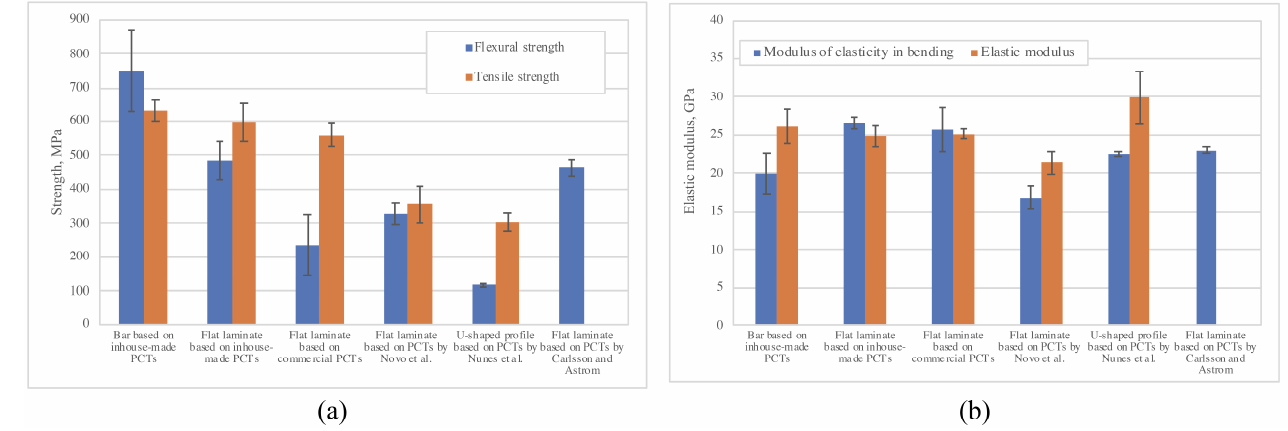
Figure 13. Mechanical properties of pultruded thermoplastic composites: ( a ) flexural and tensile strength; ( b ) modulus of elasticity in bending and elastic modulus.